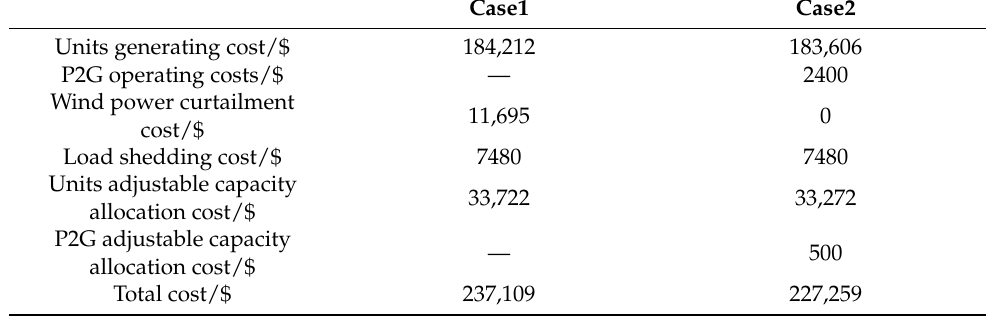
Table 1. Dispatch results of power system in two cases.